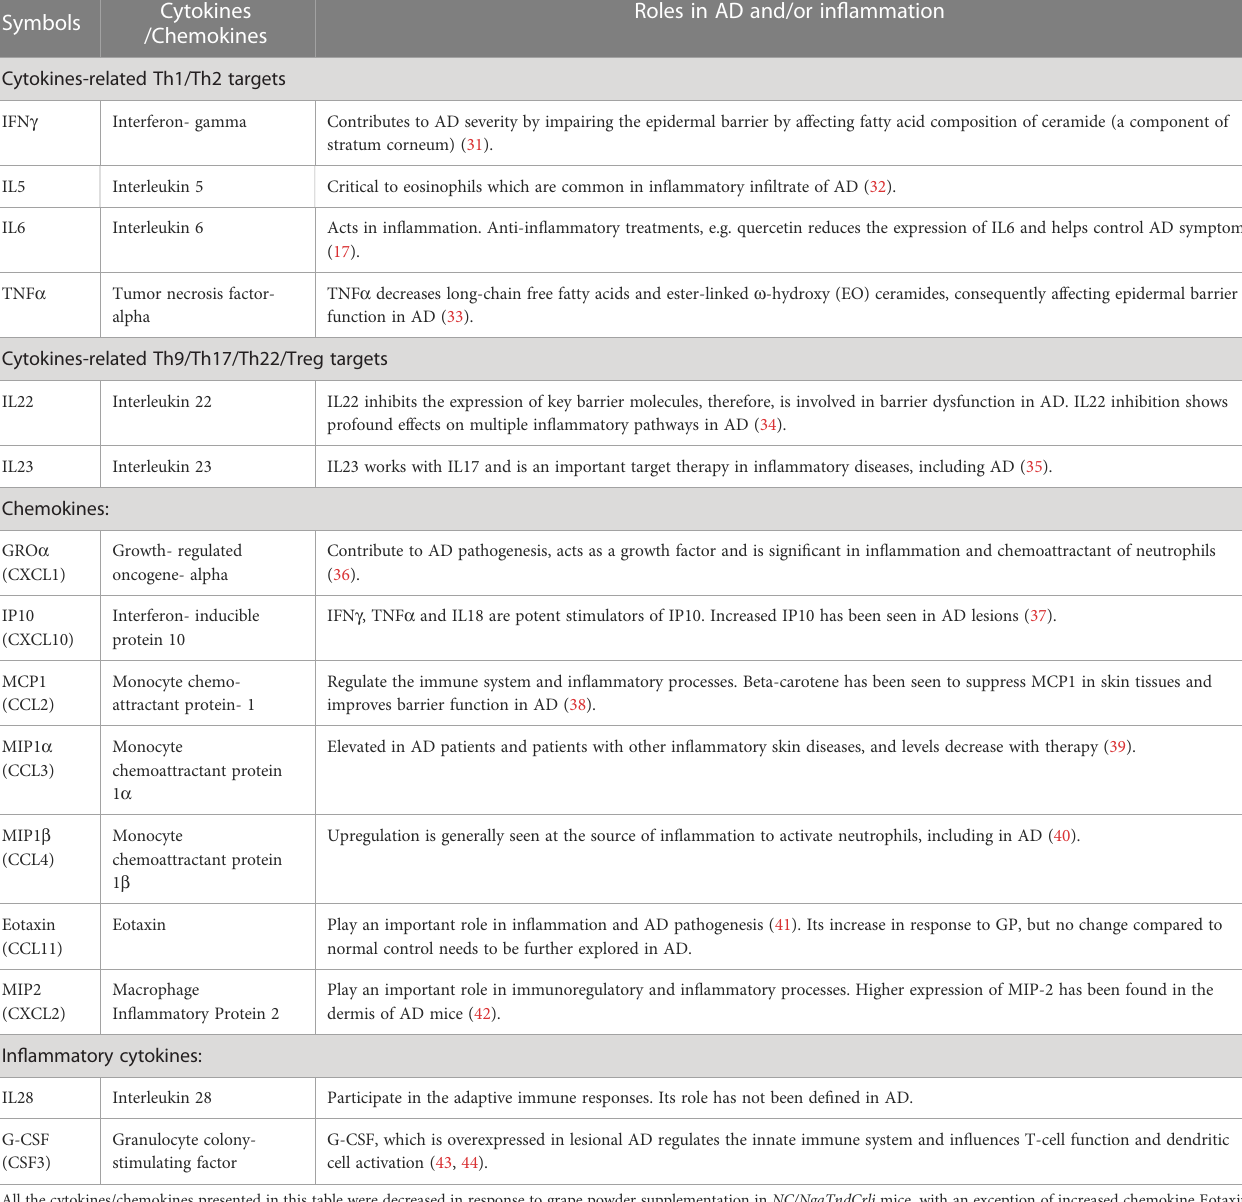
Roles in AD and/or in fl ammation